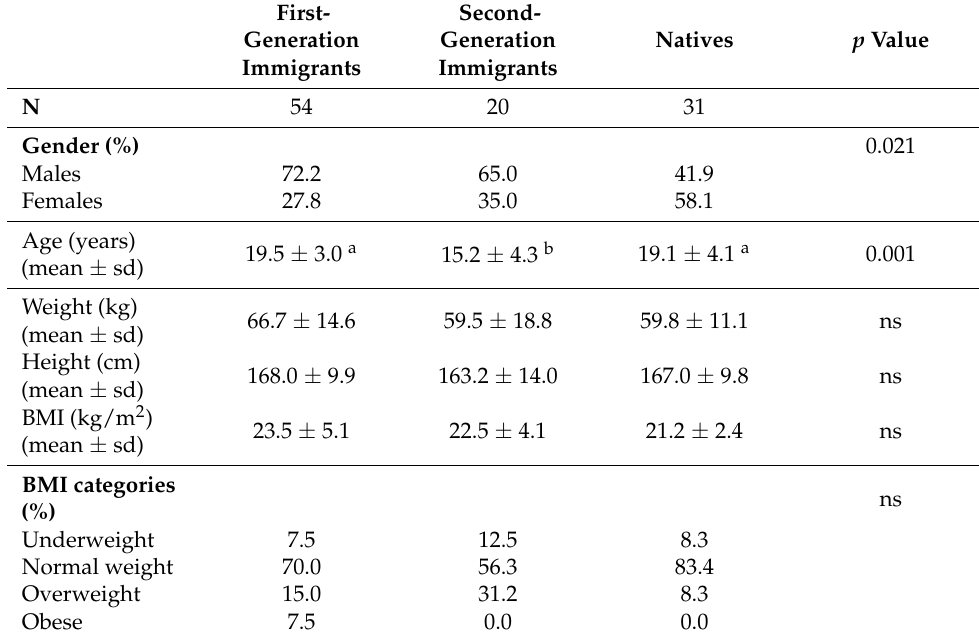
Table 1. Study sample characteristics by migration status.